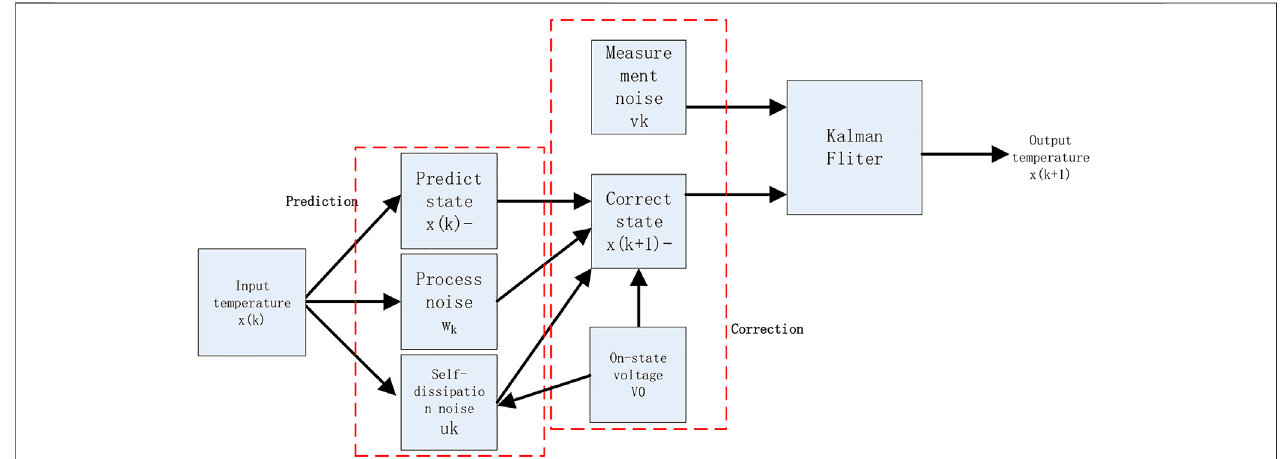
FIGURE 4 | Schematic diagram of Kalman fi ltering method in high precision temperature data processing.